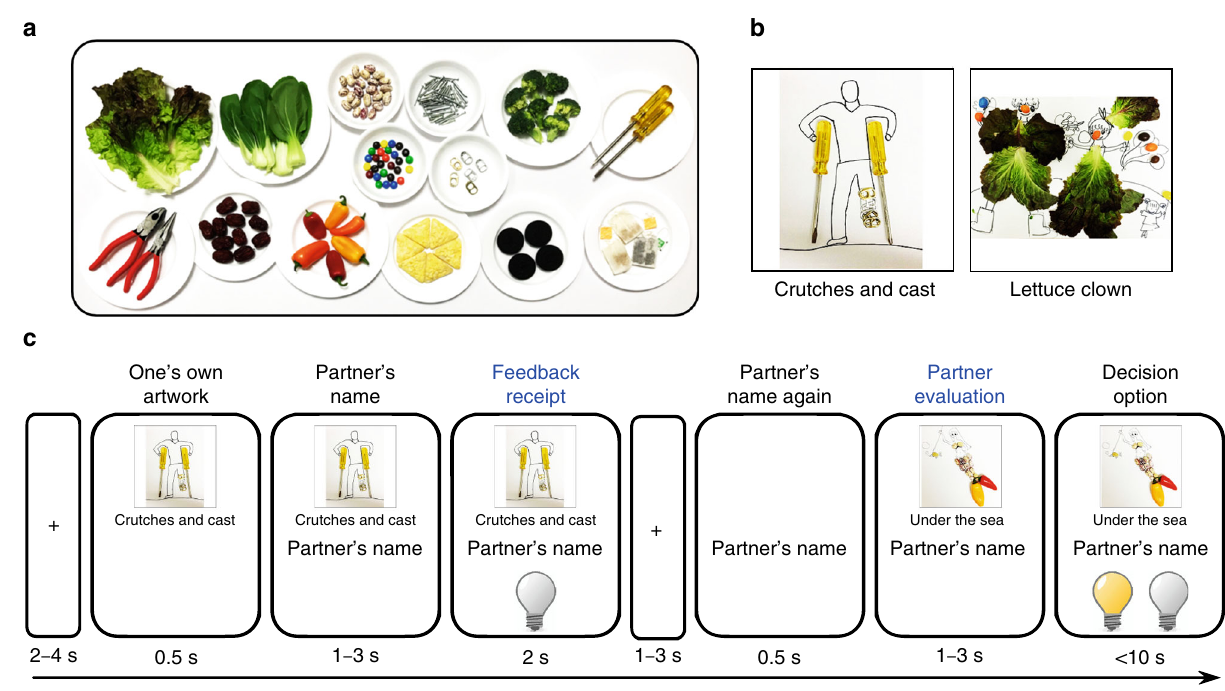
Fig. 1 Creative artwork ( fi rst visit) and reciprocal artwork evaluation (second visit) task. a Everyday materials provided for making a creative artwork ( fi rst visit). Participants were instructed to make a creative artwork by using one or two from the provided set of everyday materials and label its name. b Example artworks from an adult (left) and a child (right). c The sequence of a typical trial of the reciprocal evaluation task (second visit). In each trial, a participant saw his/her own artwork, followed by the partner ’ s name, and then viewed the partner ’ s feedback on his/her artwork. A lighted and unlighted bulb indicates “ creative ” and “ not creative ” evaluation feedback, respectively, from the partner (see Method for presentation of neutral feedback). Next, they saw the partner ’ s name again, and evaluated the partner ’ s artwork, and then made a decision about the creativity of the